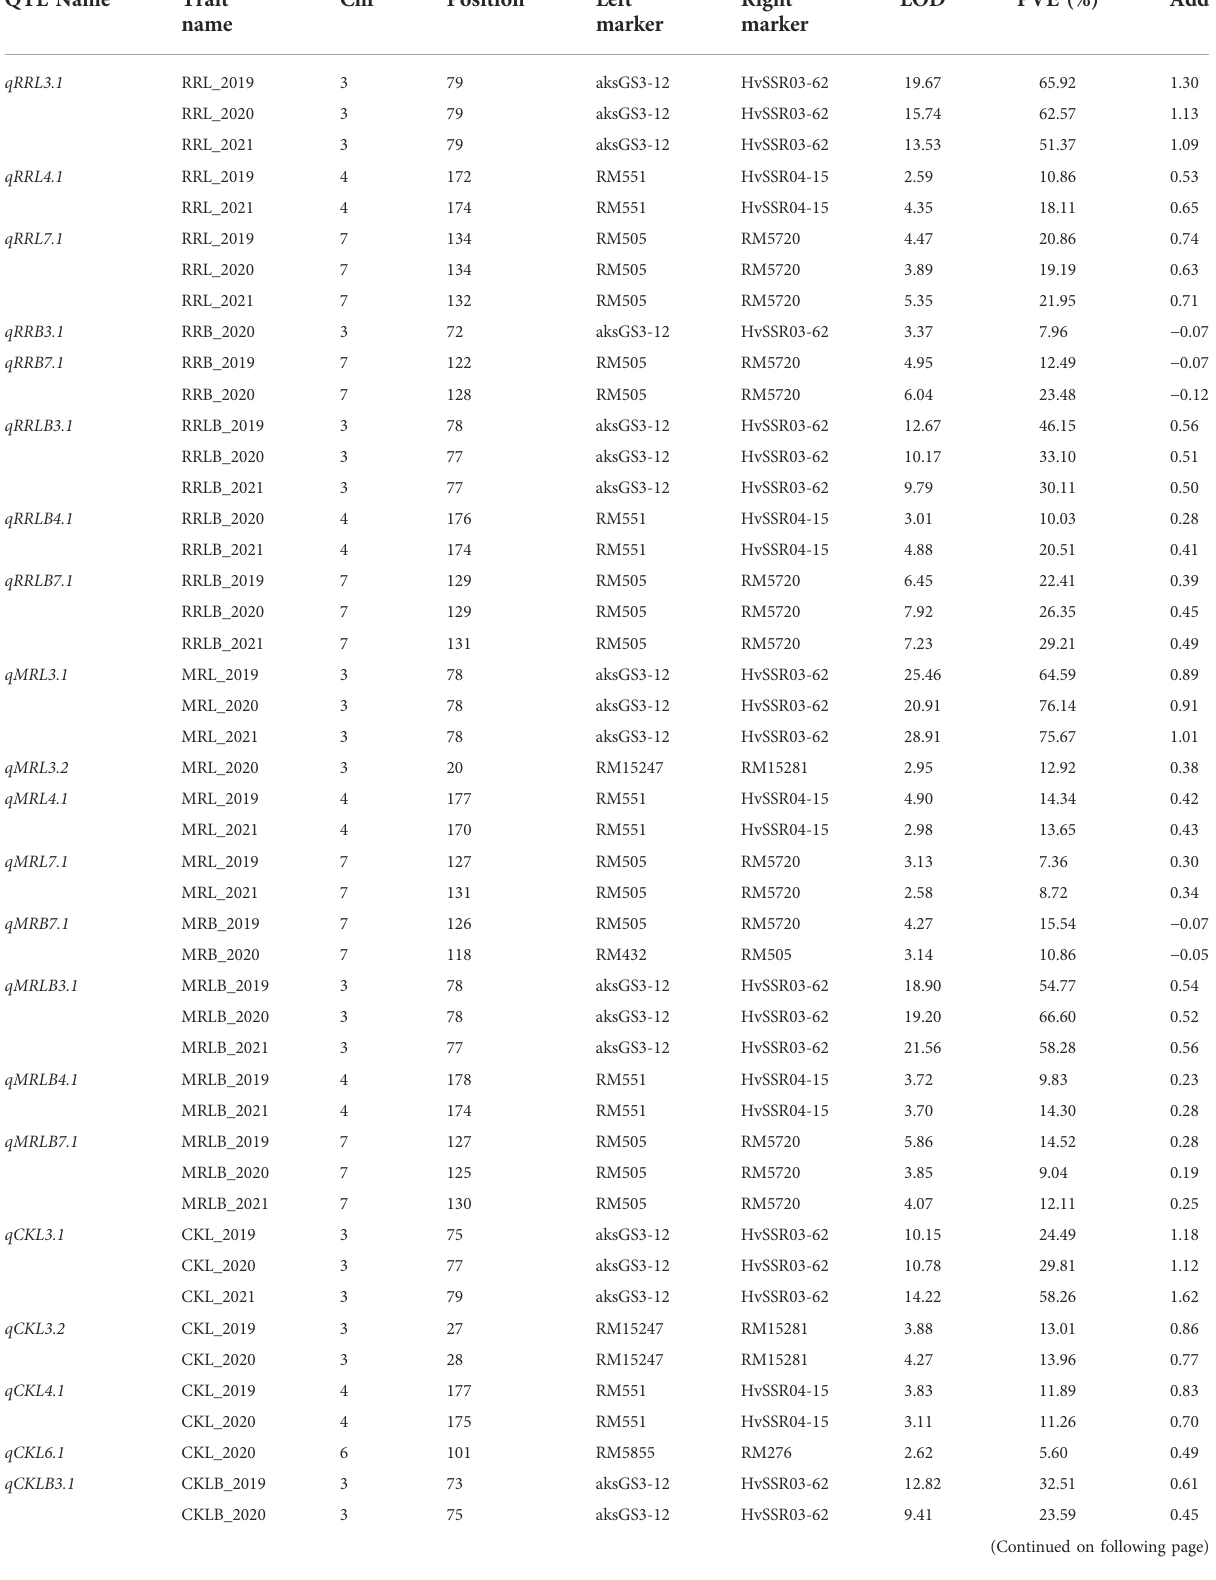
TABLE 3 QTLs identi fi ed for grain quality parameters by ICIM for three